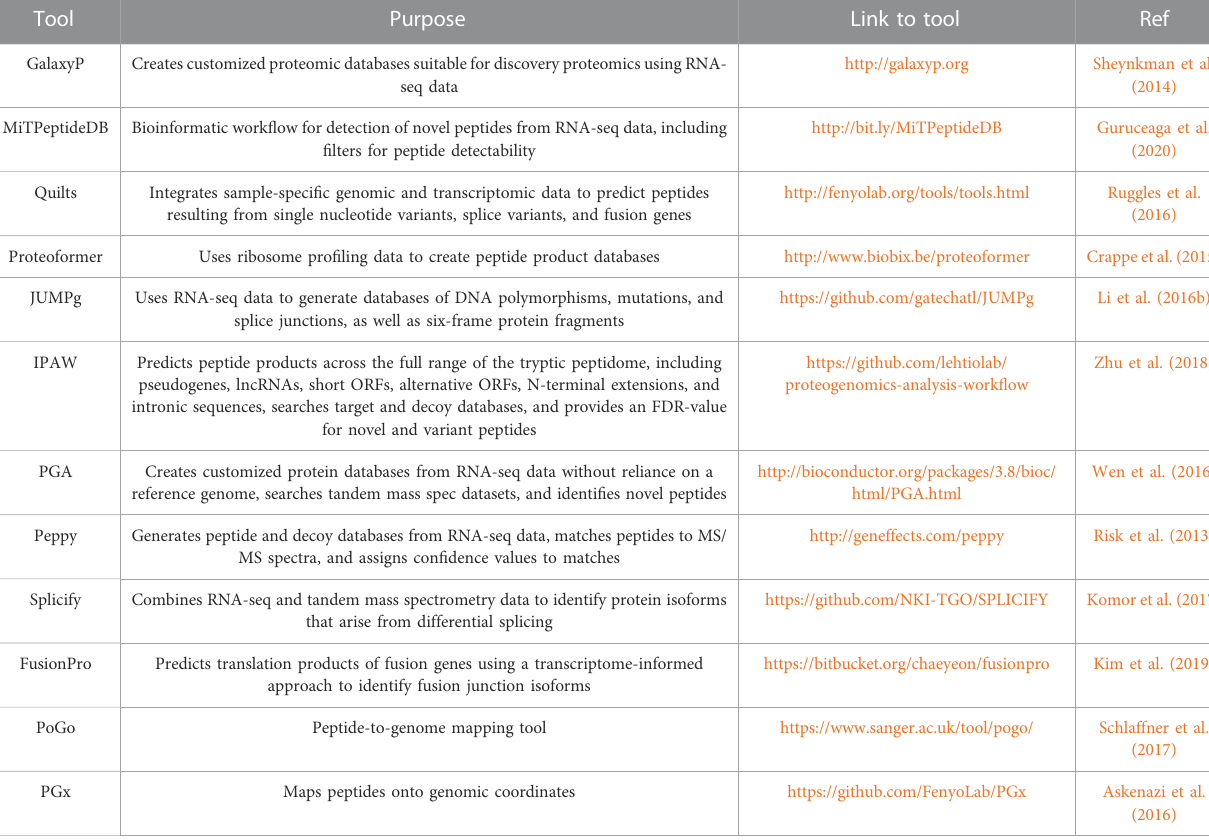
TABLE 3 Databases of common genetic variants and MS data repositories. Database Catalogue of Somatic Mutations in